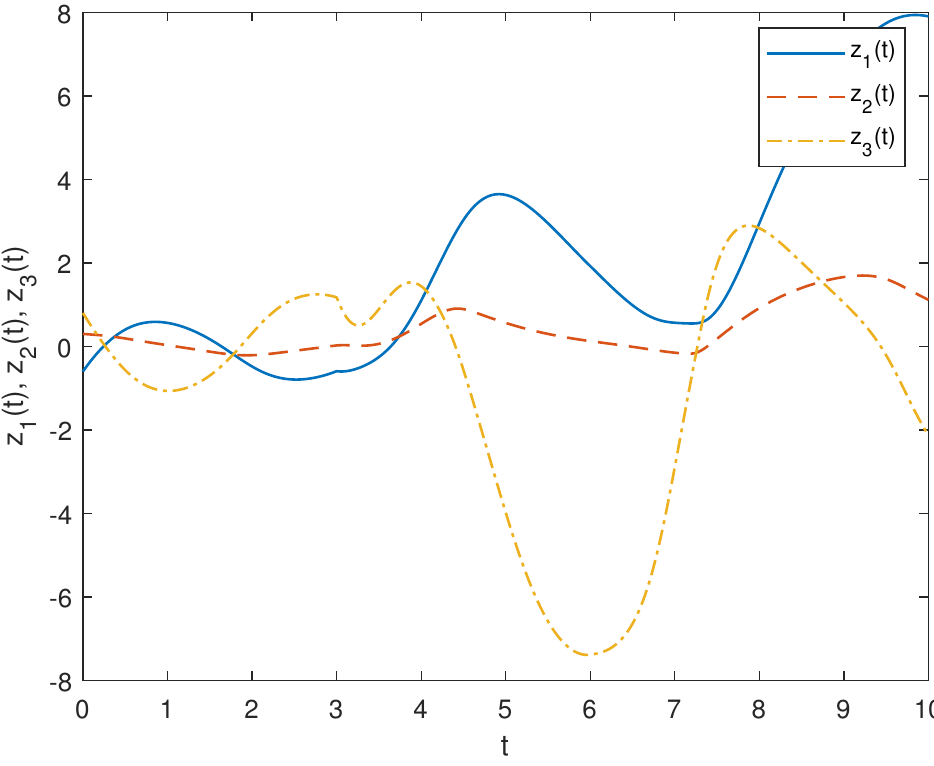
Figure 5. Trajectory of the open − loop system state for Example